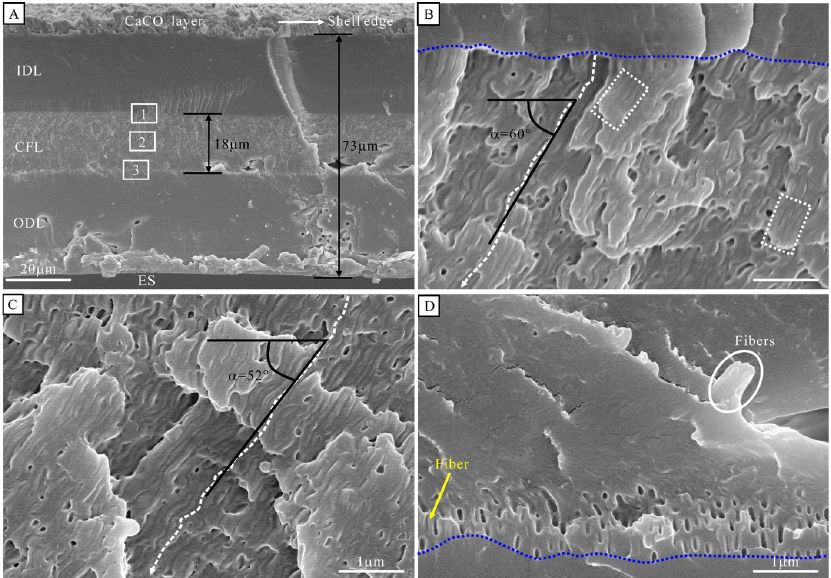
Figure 3. SEM images of an undamaged periostracum in cross-sectional fractured along the line a-a’ in Figure 1A. ( A ) full view. ( B – D ) Detail of boxed areas 1, 2, and 3 in ( A ), respectively. ES: Exterior surface, ODL: Outer dense layer, CFL: Central fibrous layer, IDL: Inner dense layer.